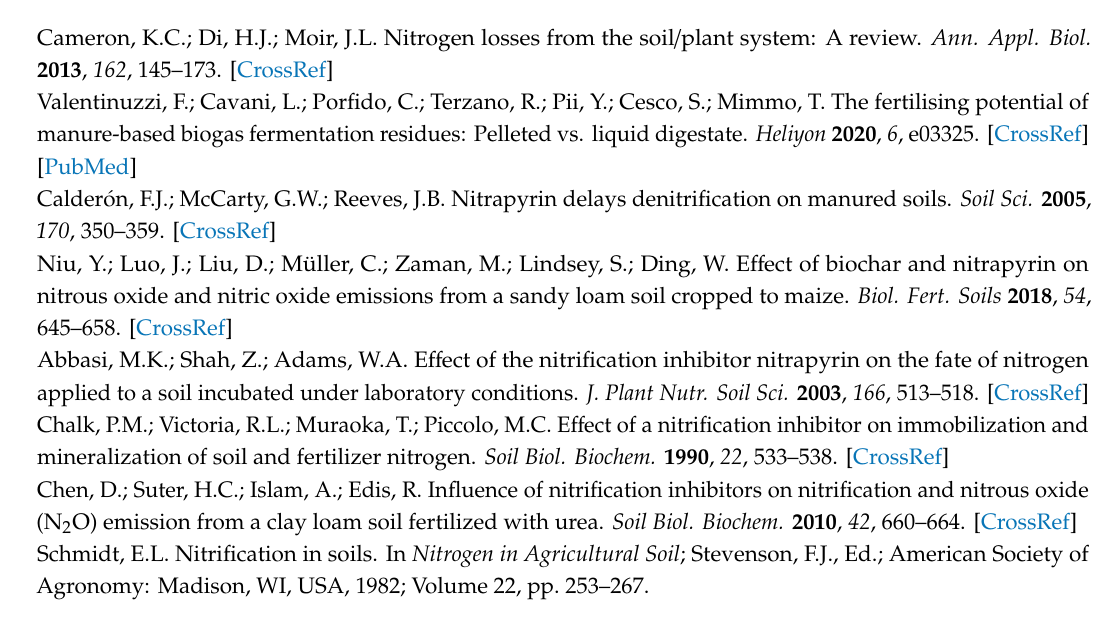
Table S1: Output of ANOVA conducted on the data on ammonium, nitrate and microbial N at time 0, 7 and 28. Author Contributions: Conceptualization, C.G., C.M., C.C. and L.C.; data curation, C.G. and M.M.; writing—original draft preparation, C.G. and M.M.; writing—review and editing, M.M. and C.C.;